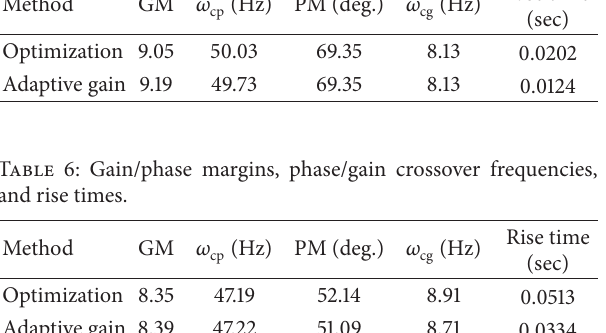
Table5:Gain/phasemargins,phase/gaincrossoverfrequencies,and rise times. Method